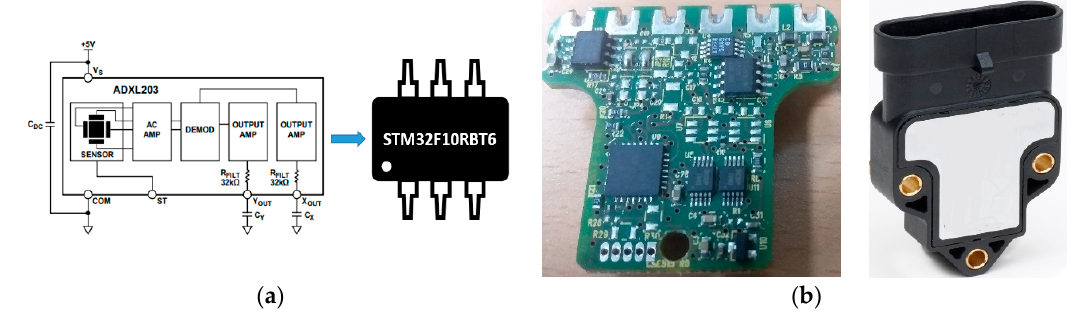
Figure 11. The F-SGBIN views as ( a ) F-SGBIN architecture; and ( b ) F-SGBIN fabrication.